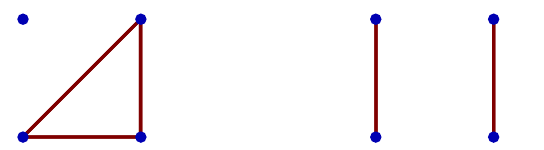
Figure 5 . Two non-equivalent graphs under edge local complementation, which have the same interlace polynomial Q = 4 x 2 ( x + y ) 2